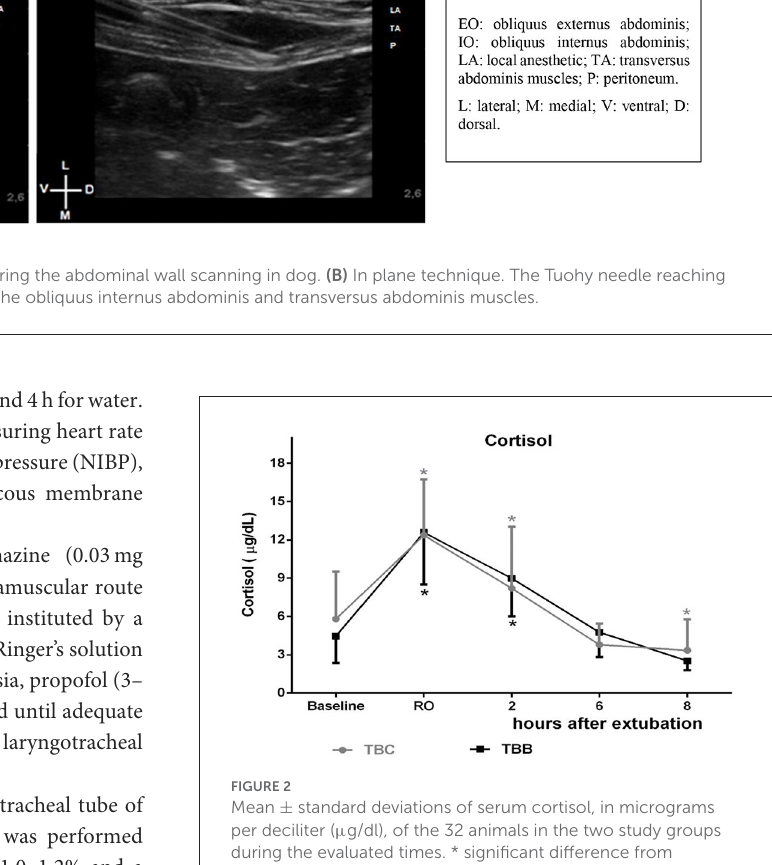
FIGURE2 Mean ± standard deviations of serum cortisol, in micrograms per deciliter ( µ g/dl), of the 32 animals in the two study groups during the evaluated times. * significant difference from